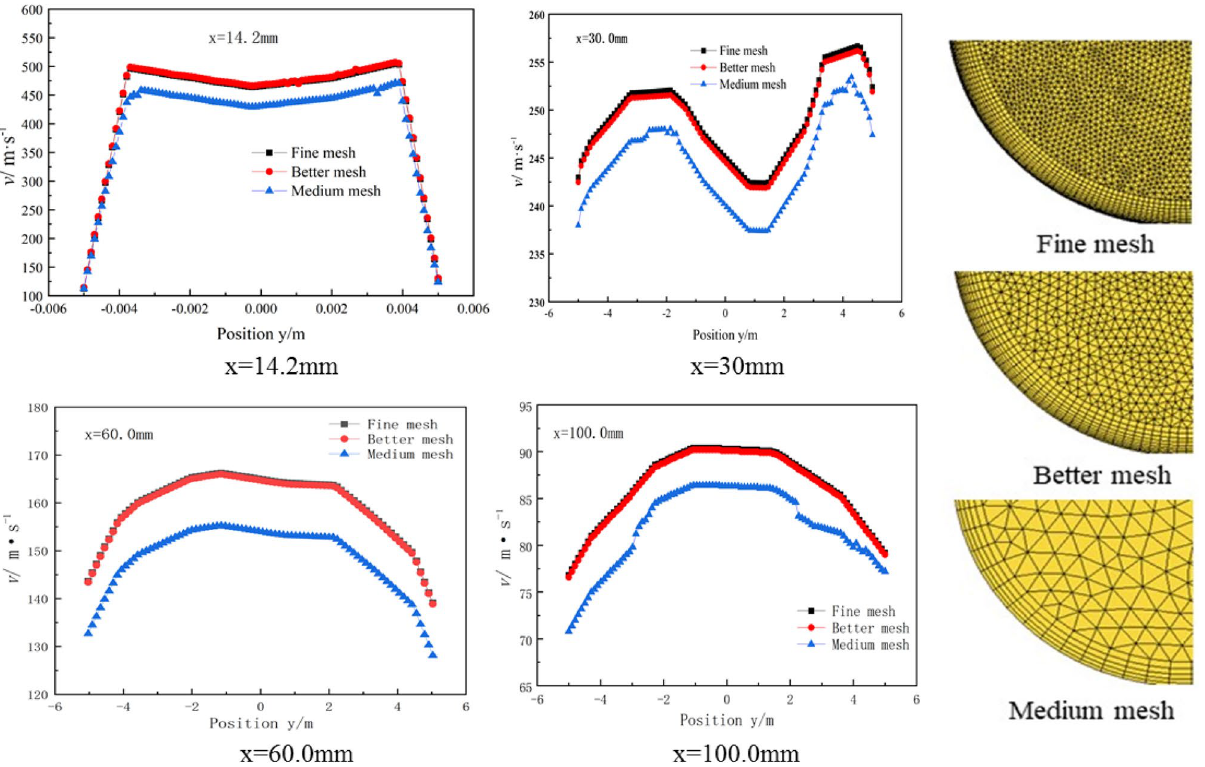
Figure 2. The comparison of the velocity at various cross-sections among three meshing cases.